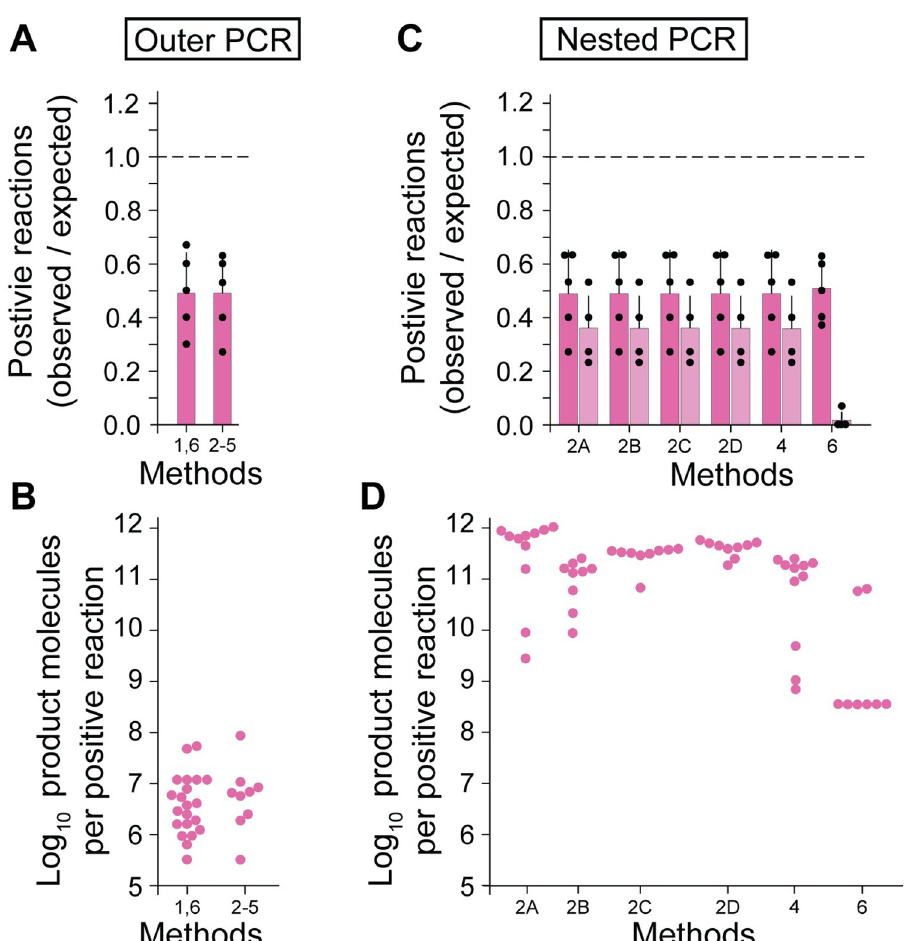
Fig 5. Amplification of intact proviruses from the J-Lat 6.3 cell line by different nFGS methods. ( A ) Number of limiting dilution outer PCRs that are positive for amplification of full-length proviruses by different nFGS methods. Carefully quantitated amounts of J-Lat DNA were diluted and plated at 30 intact proviruses/96 well plate. After amplification under conditions used by Methods 1 and 6 or Methods 2–5 (see S1 Table ), the fraction of wells with amplification was determined by IPDA. Results are expressed as the number of positive reactions per 96 well plate divided by the expected value (30/plate) for each of 5 plates (black circles). The means and standard deviations for the 5 plates tested per condition are shown as bars and black lines, respectively. ( B ) Number of product molecules generated in the positive PCRs from A . Aliquots from positive wells from a representative plated were diluted extensively and analyzed by IPDA for digital counting of product molecules. Values from individual positive wells are shown as pink circles. ( C ) Number of limit dilution wells that were positive after nested PCR amplification by different nFGS methods. After outer and nested amplification under indicated conditions (see Fig 2C and 2D and S1 Table ), the fraction of wells with amplification was determined by IPDA. Results are expressed as the fraction of positive wells relative to the expected value (30/plate) as described in A (dark pink bars). In addition, 45 ul aliquots of nested PCR wells were analyzed by agarose gel electrophoresis, and the number of wells with visible bands was determined and plotted in the same manner (light pink bars). ( D ) Number of product molecules generated in the positive PCRs from a representative plate in C . Aliquots from positive wells were diluted extensively and analyzed by IPDA for digital counting of product molecules as described in B. Values from individual positive wells are shown as pink